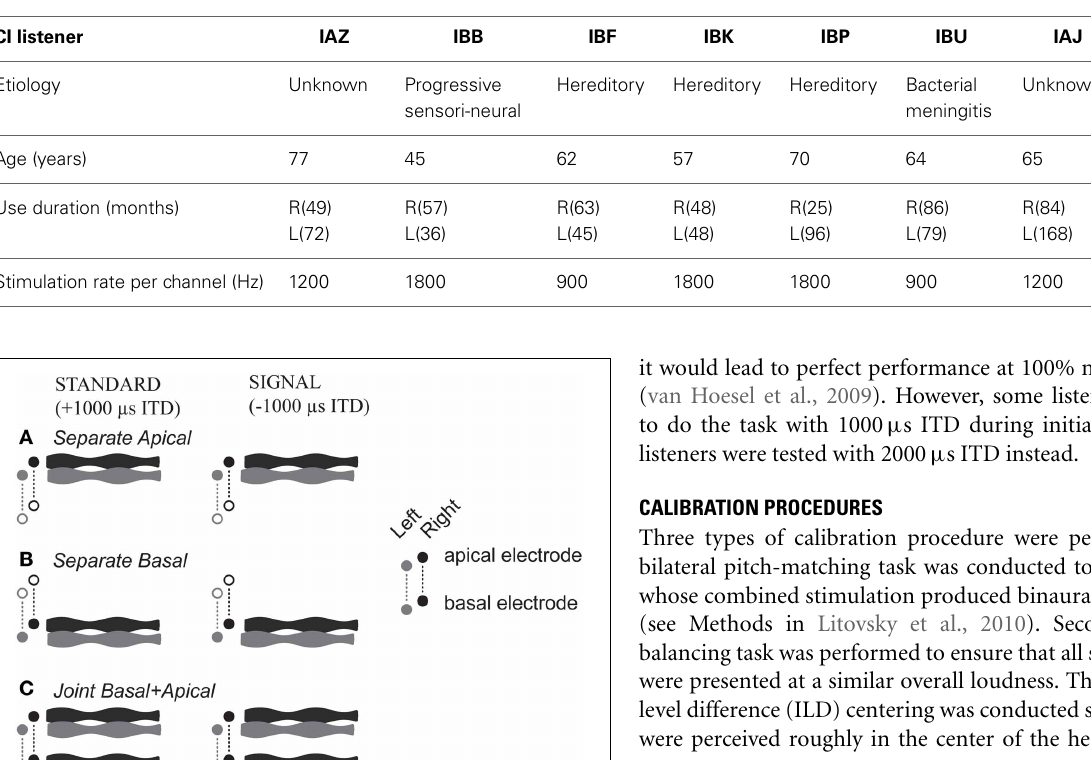
Table 1 | Clinical etiology, device: nucleus 24-electrodes.